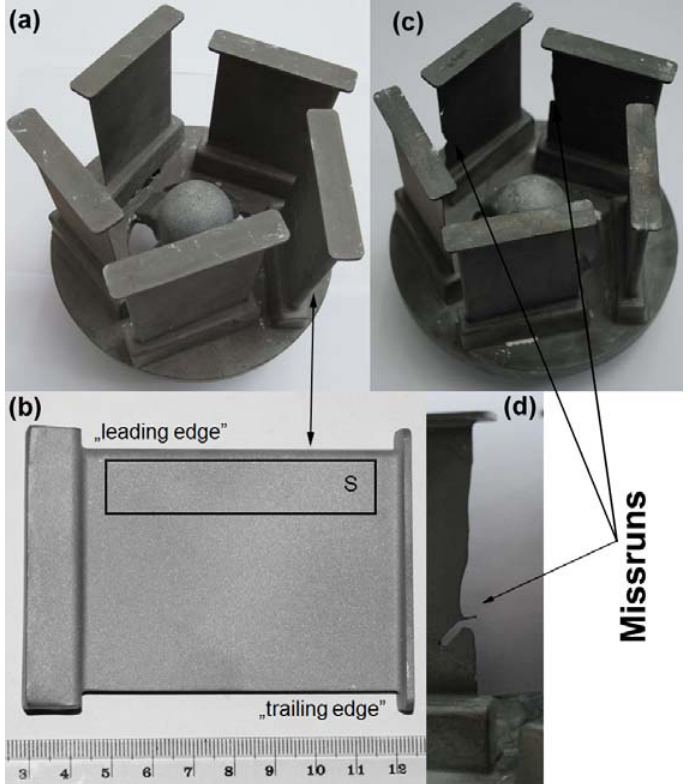
Figure 1. Examples of thin-walled wedges after knock-out: ( a ) and ( b ) T = 1250 °C, where S denominates the sampling area; ( c ) and ( d ) T T s T = 1000 s